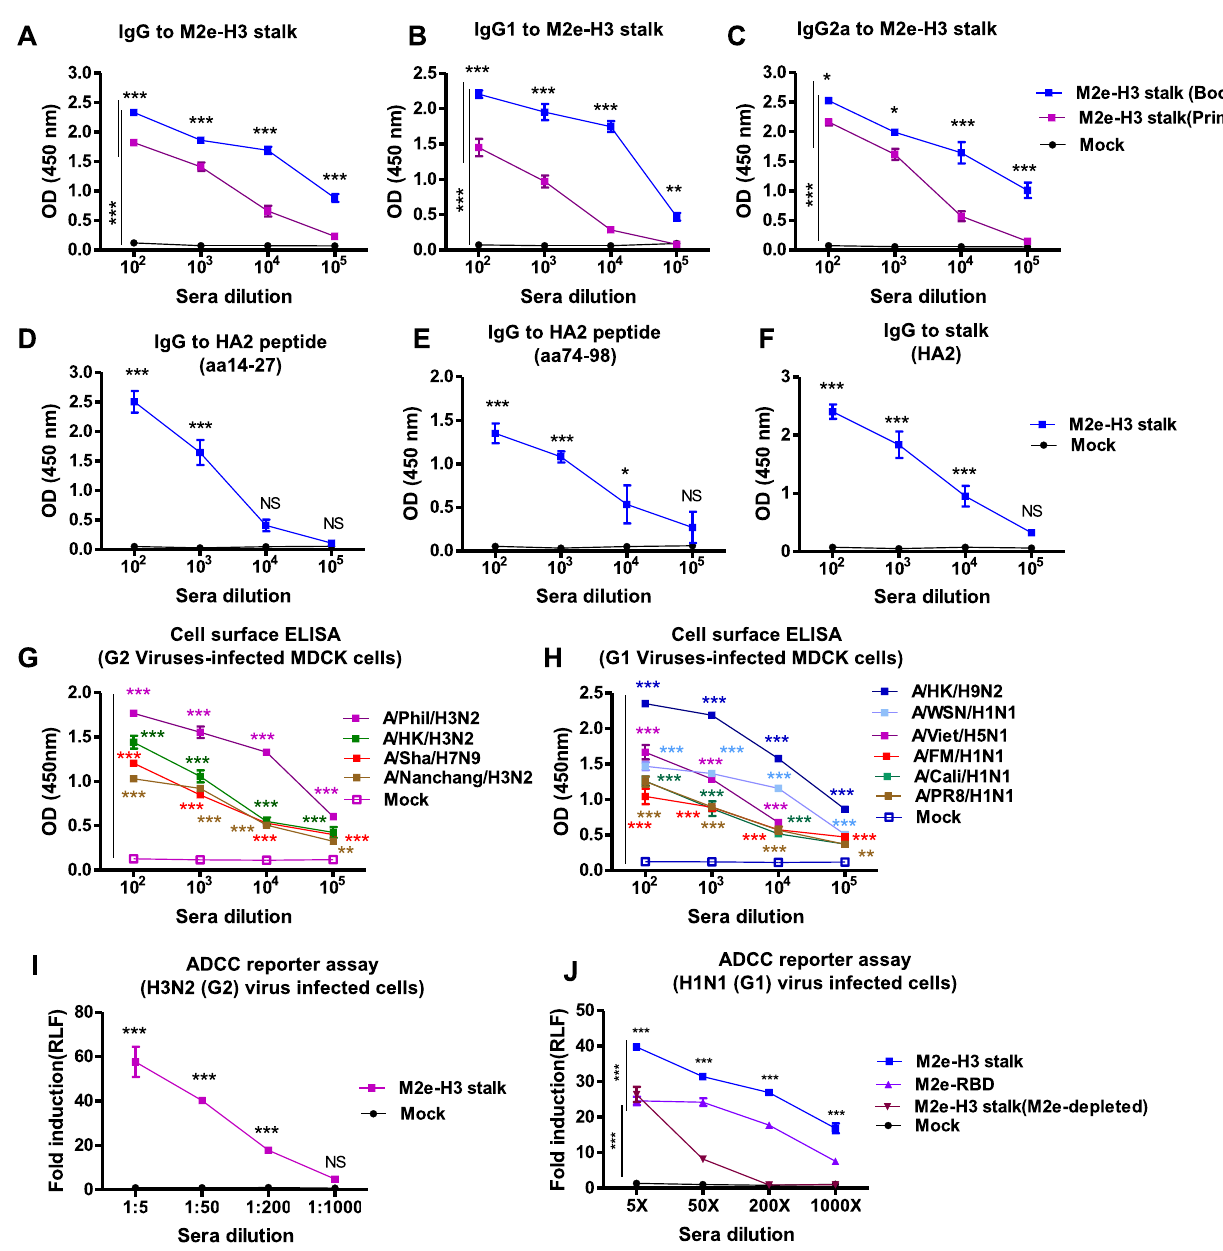
Fig. 3 Adjuvanted M2e-H3 stalk vaccination induces antibodies recognizing M2e, FP, stalk, and group 1 and 2 viral antigens and virus- infected cell surface. BALB/c mice ( n = 10) were intramuscular (i.m.) prime-boost immunized with adjuvanted M2e-H3 stalk (20 µg) protein. IgG antibodies and ADCC were determined in sera collected 2 weeks after vaccination. A – C IgG and IgG antibody subtypes speci fi c for M2e- H3 Stalk protein. IgG ( A ), IgG1 ( B ) and IgG2a ( C ) antibodies speci fi c for M2e-H3 stalk protein. D – F stalk-speci fi c IgG antibodies in boost sera. IgG antibodies speci fi c for HA2 FP epitope region aa14-27 of HA2 ( D ), stalk epitope residues aa74-98 of HA2 ( E ), and full-length stalk protein (aa 1-185 of HA2) ( F ). G , H M2e-H3 stalk vaccination induced IgG antibodies recognizing both group 2 ( G ) and group 1 ( H ) viral antigens on the surface of virus-infected MDCK cells. I , J Antibodies induced by M2e-H3 stalk vaccine engage in Fc-mediated activation of Jurkat effector cells, mimicking a surrogate ADCC activation pathway. Group 2 virus (G2) A/Phil/H3N2(H) and group 1 virus (G1) A/WSN/H1N1 ( J ). Mock: adjuvanted naïve sera, M2e-depleted: M2e-speci fi c IgG depleted M2e-H3 stalk sera. Statistical signi fi cance was determined by using two-way ANOVA; error bars indicate mean ± SEM; * P < 0.05;** P < 0.01; *** P < H3N2 (Fig. 3G). Interestingly, antisera of M2e-H3 stalk vaccination were also highly reactive to the cell surface viral antigens after infection with group 1 in fl uenza viruses (A/Cal H1N1, rgA/HK